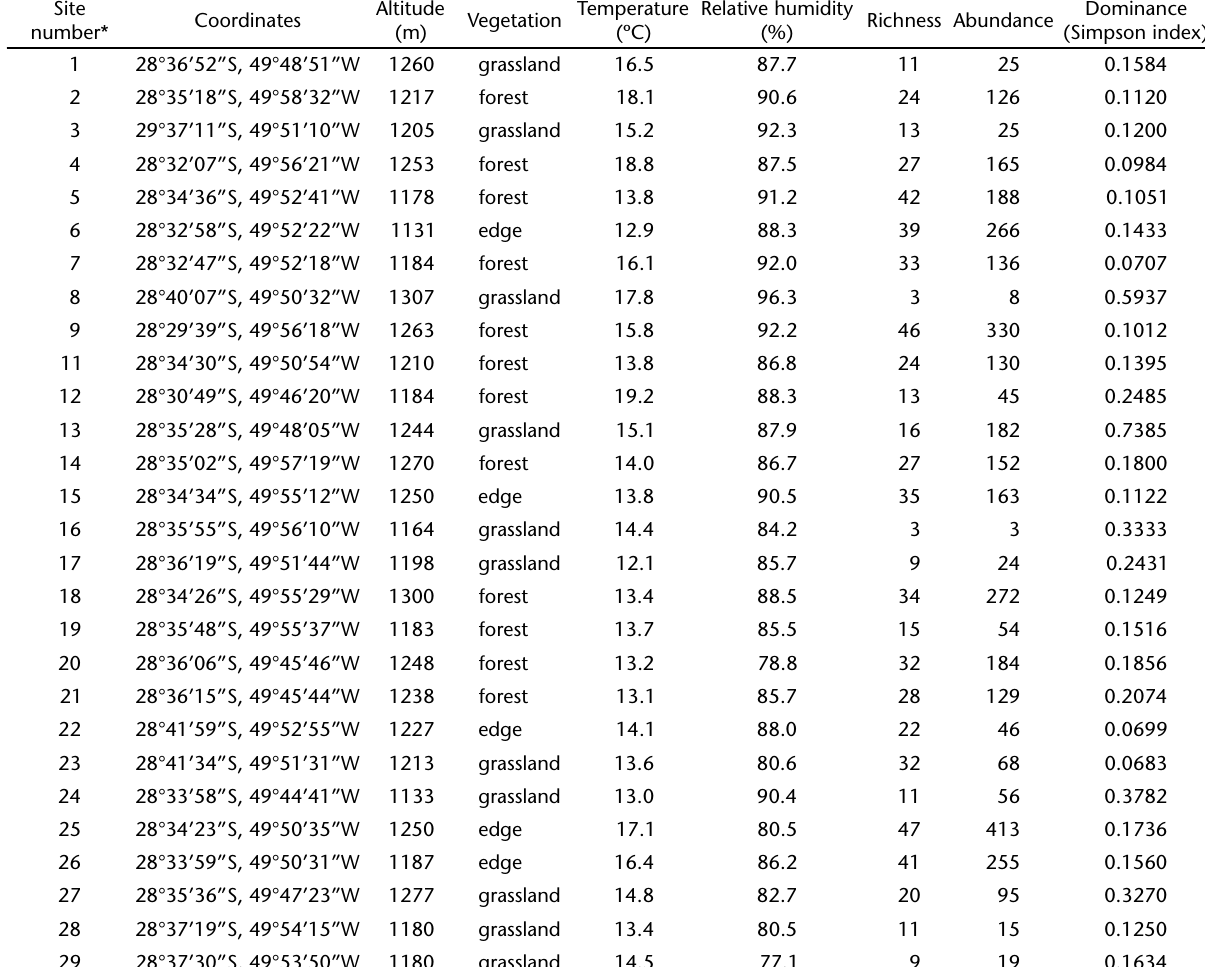
Table I. Geographical coordinates, altitude, vegetation type, mean temperature, mean relative humidity, species richness, abundance, and dominance of tiger moths at each sampling site. São José dos Ausentes, southern Brazil. Summers 2007-8. Site